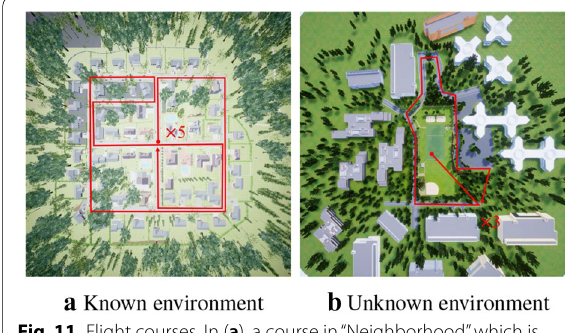
Fig. 11 Flight courses. In ( a ), a course in “Neighborhood” which is a known environment for the DNN is shown. The drone flew for 5 rounds. It took about 22 minutes. In ( b ), a course in “SoccerField” which is an unknown environment for the DNN is shown. The drone flew for 3 rounds. It took about 6